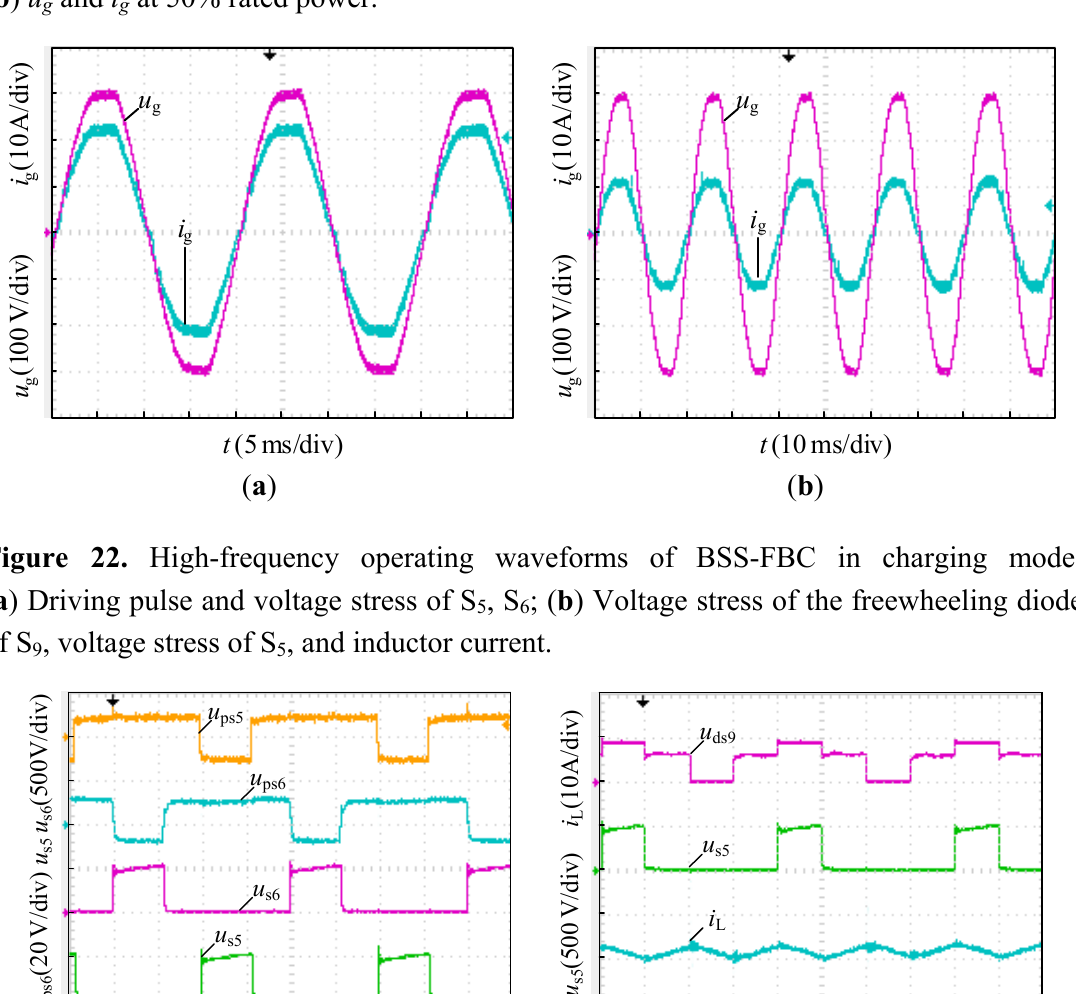
and i at 100% rated power; g g